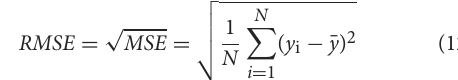
RMSE: Root Mean Squared Error is the square root of Mean Squared error. It measures the standard deviation of